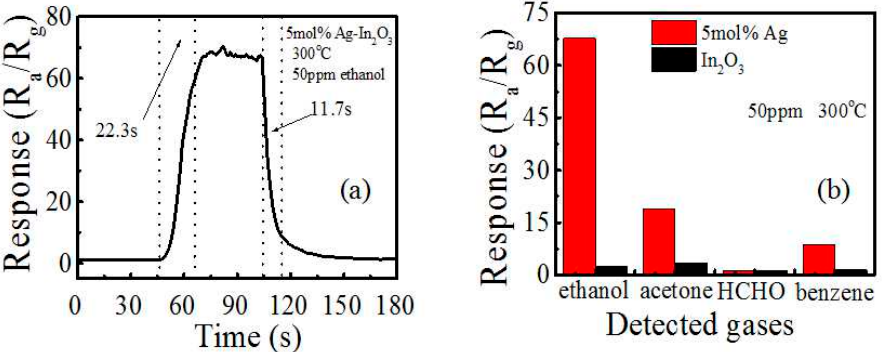
Figure 6. ( a ) The response-recovery characteristics of the 5 mol % Ag-modified In 2 O 3 sensor to 50 ppm ethanol at 300 °C; ( b ) the response of the 5 mol % Ag-modified In 2 O 3 sensor to 50 ppm of different gas concentrations at 300 °C.